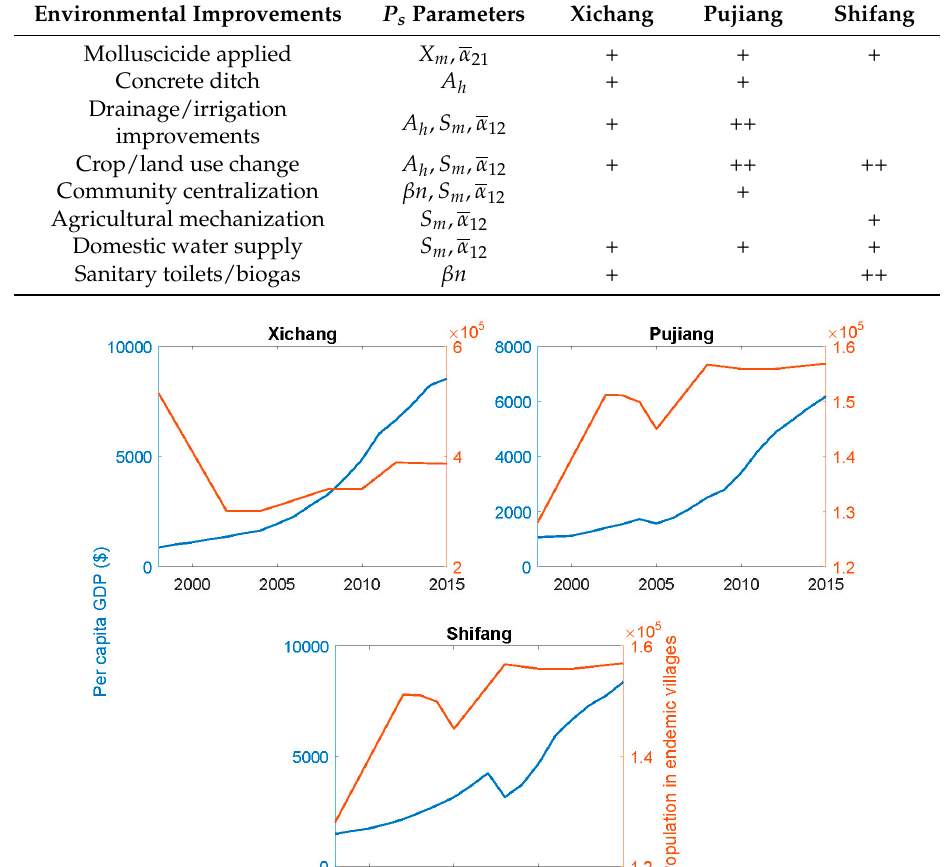
Figure 5. Per capita GDP and resident population numbers in endemic villages in the three counties.